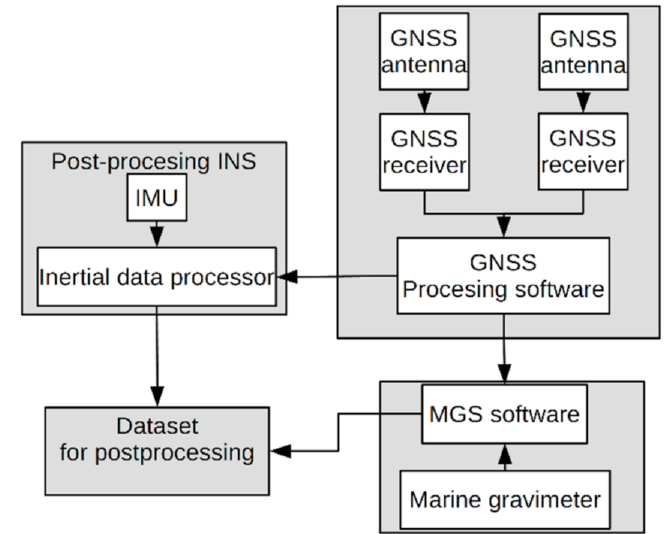
Figure 1. The scheme showing the flow of data during the measurement campaign. Abbreviations used: Global Navigation Satellite Systems (GNSS), Inertial Navigation System (INS), Inertial Measurement Unit (IMU), Marine Gravity System